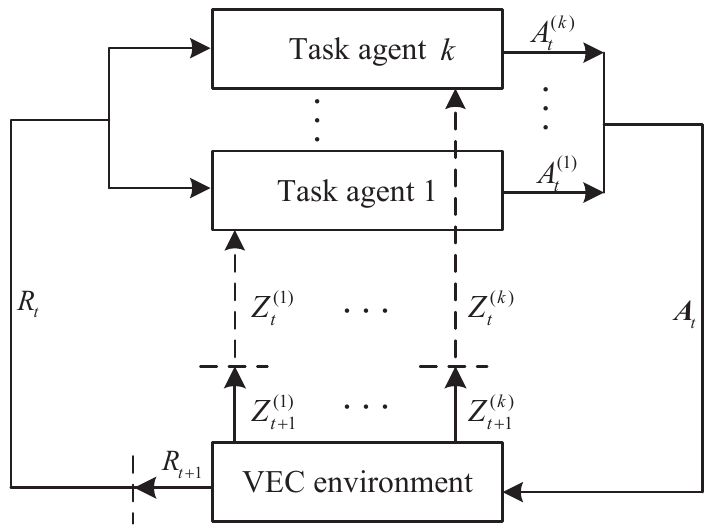
Figure 3. The multi-agent environment interaction with the DRL-based